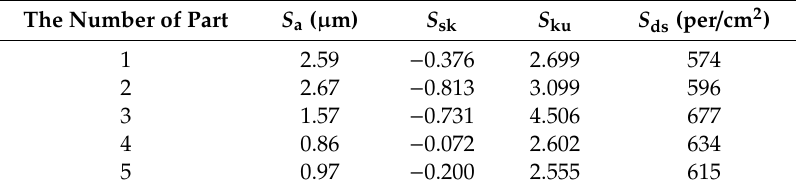
Table 3. Surface parameters of the contact arc along the